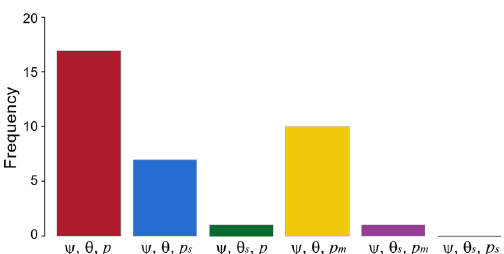
Figure 1. Frequency of best models explaining detection estimates of 36 bird species recorded in ponds in south-eastern Spain. For each species, six candidate models were considered (see descriptions in Table 2). The selection procedure for each species was based on the lowest AICc value. The figure was created in R (version 4.0.2, https ://www.R-proje ct.org/) and assembled with GIMP (version 2.10.14, https